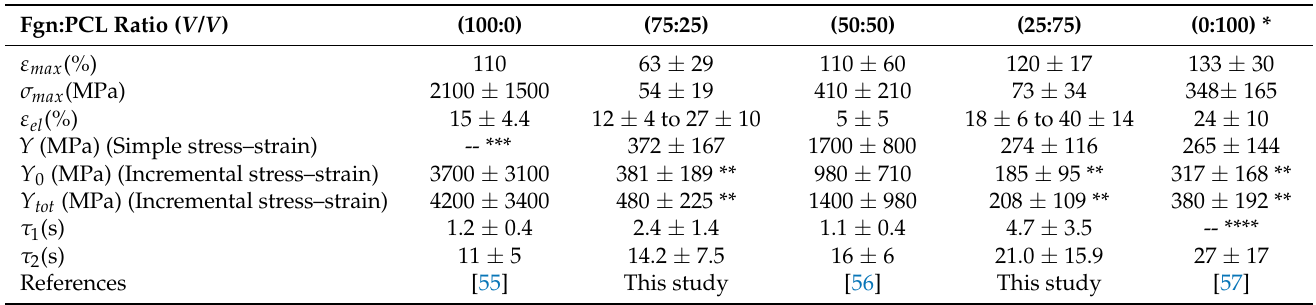
Table 3. Mechanical properties of dry, electrospun fibrinogen:PCL nanofibers at different blending ratios. Maximum strain (extensibility), ε max , maximum stress, σ max , elastic limit, ε el , Young’s modulus (initial slope of stress–strain curve), Y , relaxed, elastic modulus Y 0 , and total modulus, Y tot , fast and slow relaxation times, τ 1 and τ 2